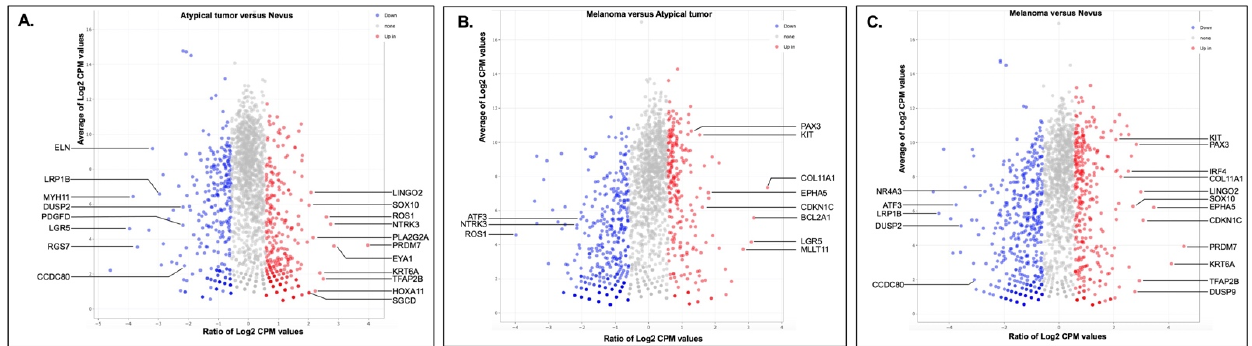
Figure 2. The MA plots showing upregulation and downregulation of the genes between each of the two BAP1-inactivated melanocytic lesions. ( A ) Atypical tumor versus Nevus; ( B ) Melanoma versus Atypical tumor; ( C ) Melanoma versus